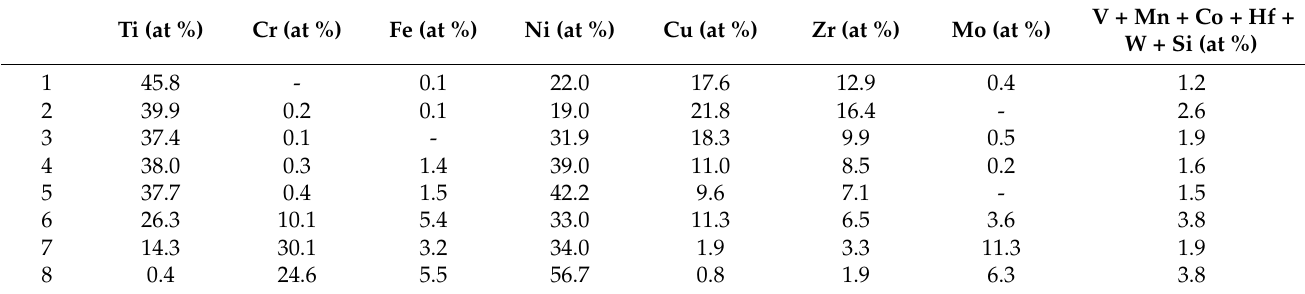
Table 4. Composition (at %) measured by means of the EDS analysis of the points and areas indicated in Figure 7b.